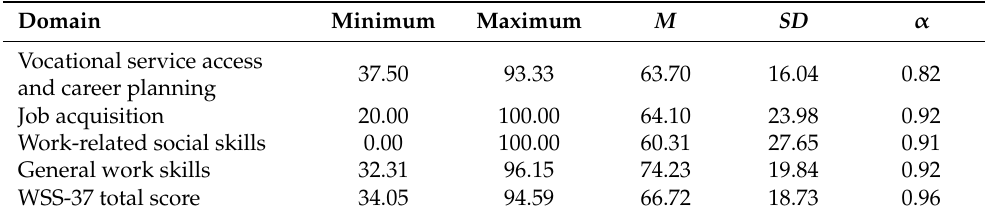
Table 2. Descriptive statistics and Cronbach’s alphas of the work-related self-efficacy scale (WSS-37) Domains and total